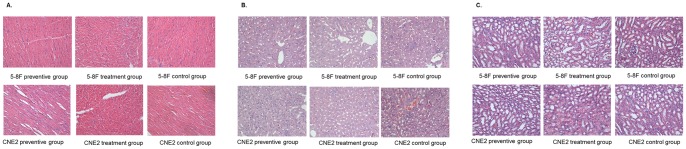
The result of HE staining of main organs of nude mice after I3C treatment.(A) HE staining of heart, (B) HE staining of liver, (C) HE staining of kidney.